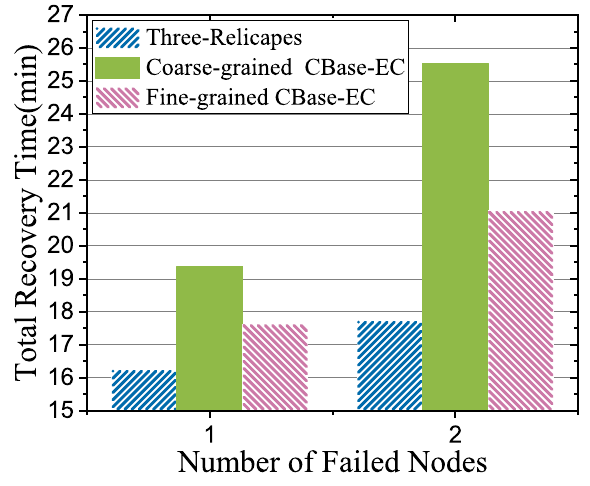
Figure 9. Parallel repair